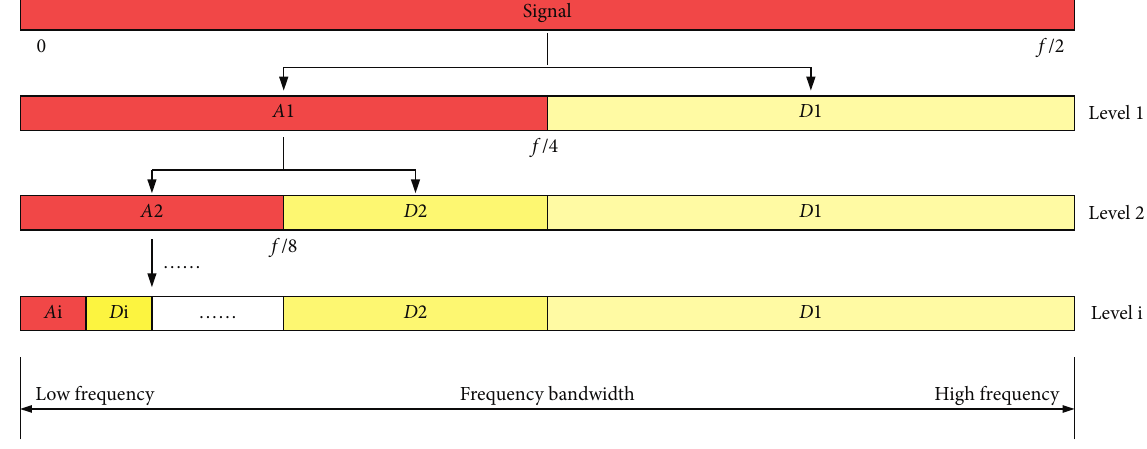
Figure 3: The schematic representation of wavelet method.